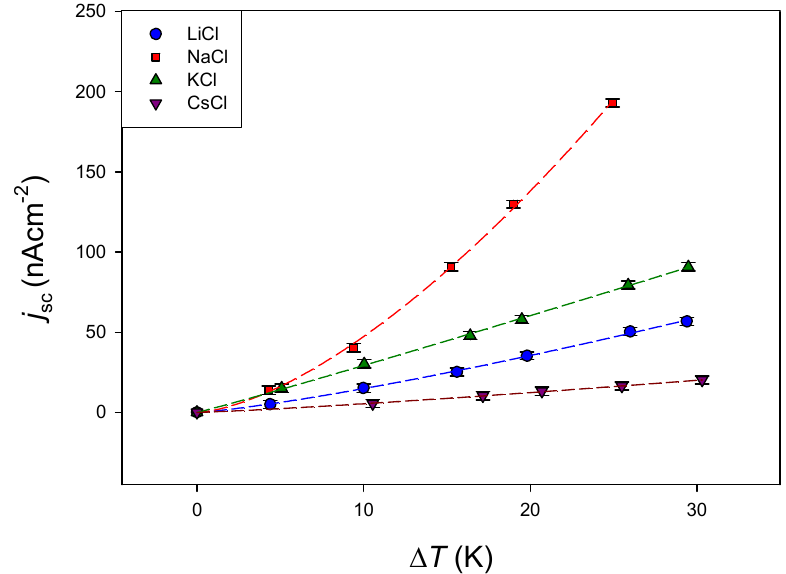
Figure 6. Short-circuit current density versus temperature difference for CR61 at different 10 − 4 M electrolytes and natural convection. Mean temperature: 25 °C. Lines corresponds to the fit of the experimental data to Equation (7). Table 3. Short circuit density per K of temperature difference for the different electrolytes. Values correspond to linear fits of the experimental data shown in Figure 6.